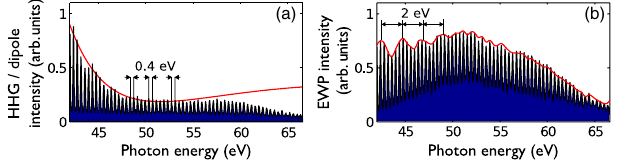
FIG. 3. (a) Measured HHG spectrum with 0.4-eV harmonic peak spacing (blue area), taken out of the spectrogram shown in ¼ 2 . 6 π . The red line shows Fig. 4(a) for ϕ 2 ¼ 1 . 19 π and ϕ CEP the squared recombination dipole matrix element for argon, calculated by Fabre for Ref. [27]. (b) The same HHG spectrum divided by the squared recombination dipole matrix element gives the corresponding REWP spectrum. The red line shows the slowly varying spectral envelope, found by performing a peak search for the harmonic peaks and subsequent cubic spline